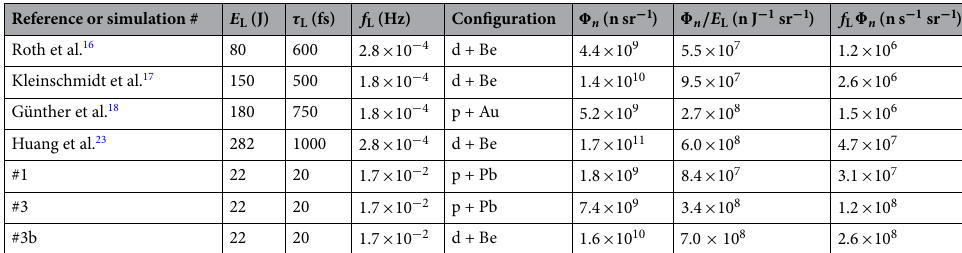
Table 2. Comparison of the optimum neutron sources studied in this work with state-of-the-art published results. The first column details the reference or simulation case considered (experimental works are highlighted in bold). The next three columns present the corresponding laser pulse energy ( E L ), duration ( τ L ), and the shot frequency ( f L ). The fifth column details the ion projectile and the converter material, and the last three columns summarise the total neutron yield per unit solid angle ( (cid:31) n ), the neutron yield normalised to the laser energy ( � n / E L ) and the time-averaged neutron yield ( f L (cid:31) n